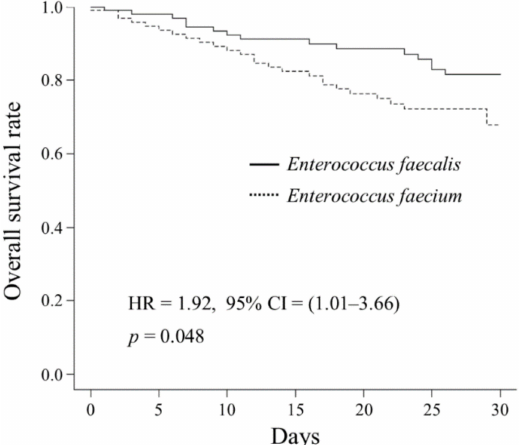
Figure 1. Kaplan–Meier survival curves of patients with E. faecalis and E. faecium